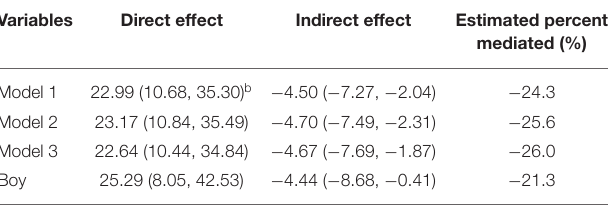
TABLE 5 | Mediating effects of gestational weight gain (kg) (n = 2,793) a